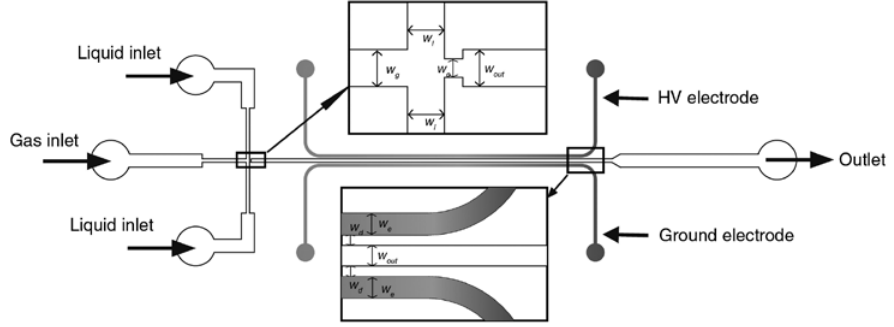
Figure 8: A plasma microreactor in which the plasma can be regenerated in gas bubbles along the main channel.